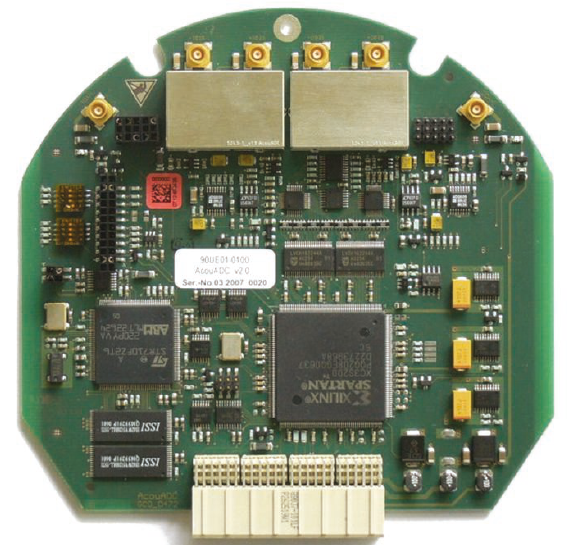
Figure 5: An AcouADC board. Metal covers on the analog part are for